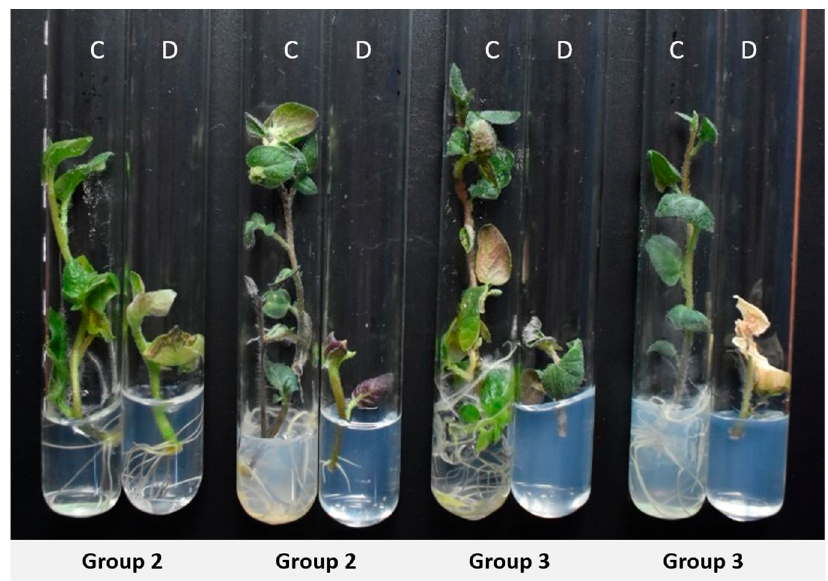
Figure 3. Morphological differences of severe drought-stressed (D) and control (C) plants after three weeks on 15% PEG media. Representative genotypes of Group 2 shown from left to right: DkS10.13, DkDN5.11; of Group 3: DkDN5.6 and DkDN11.26.